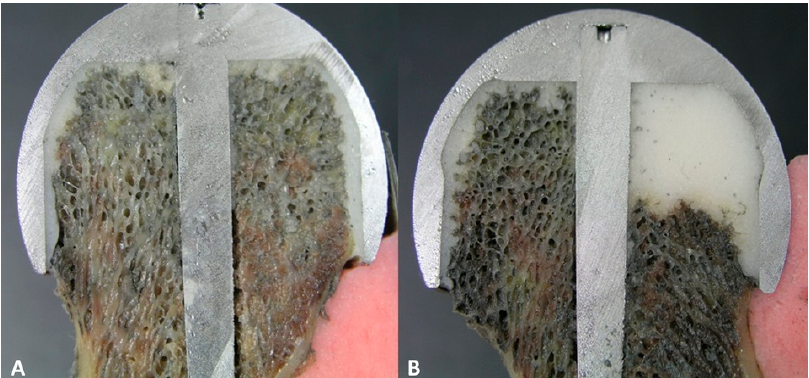
Figure 4. Cross sections of the femoral specimens. ( A ) In the control group, bone cements were used to fill the gap between bone and the implant. There were no other bone defects filled with bone cement. ( B ) In the experimental group, bone defects were used to sufficiently fill 50% of the bone defects. There were no other bone defects.